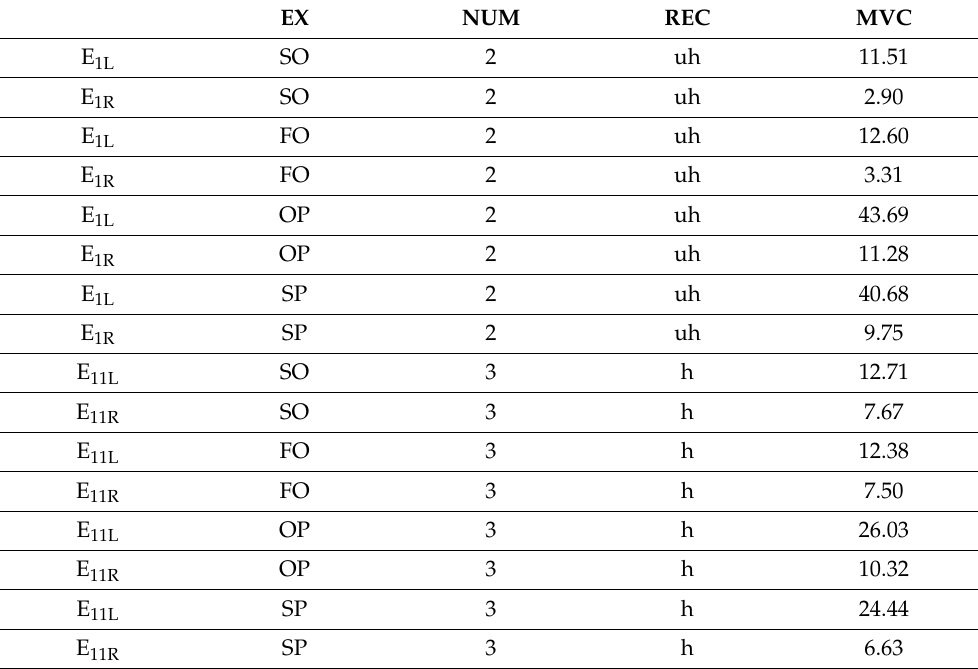
Table 3. Examples of EMG features